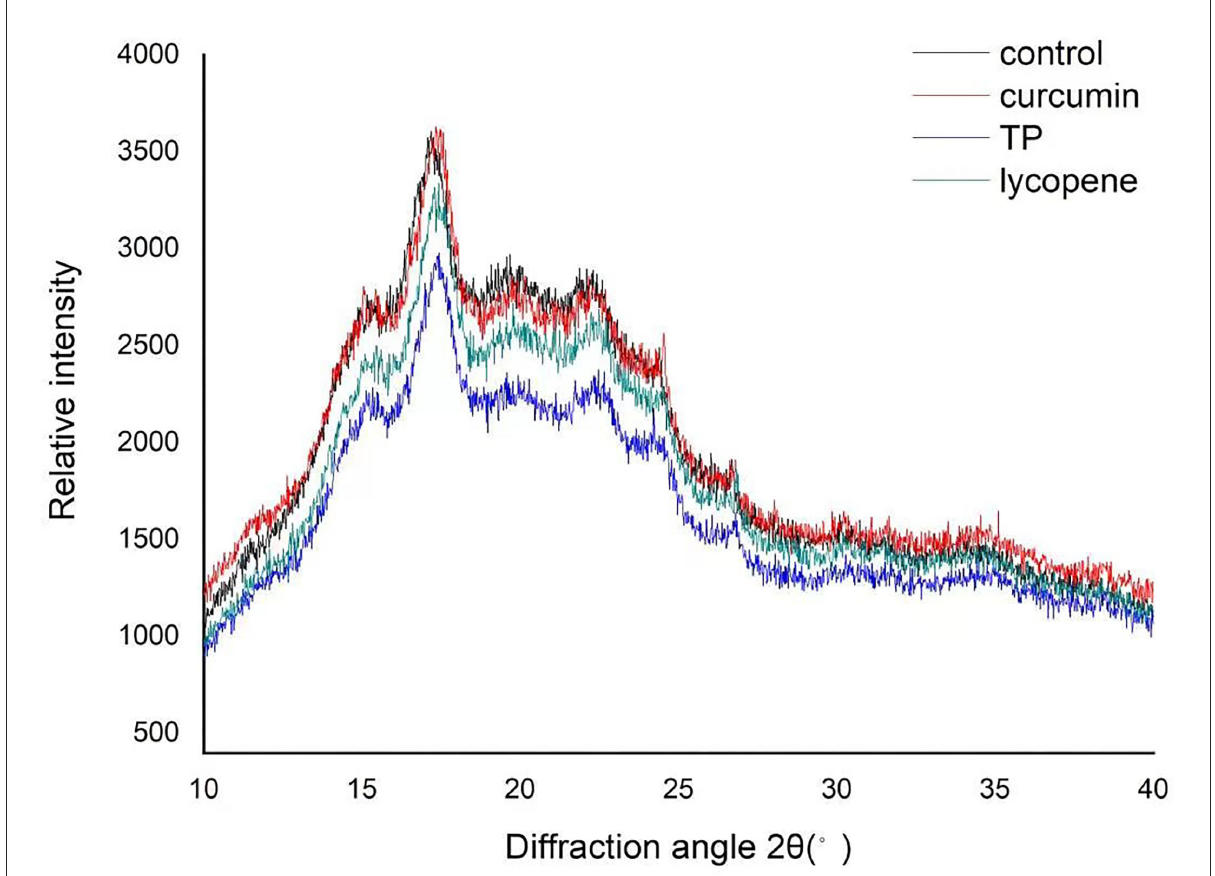
FIGURE5 X-ray diffractogram of NASNs contained curcumin (red), TP (blue), lycopene (green), and SN without NAs